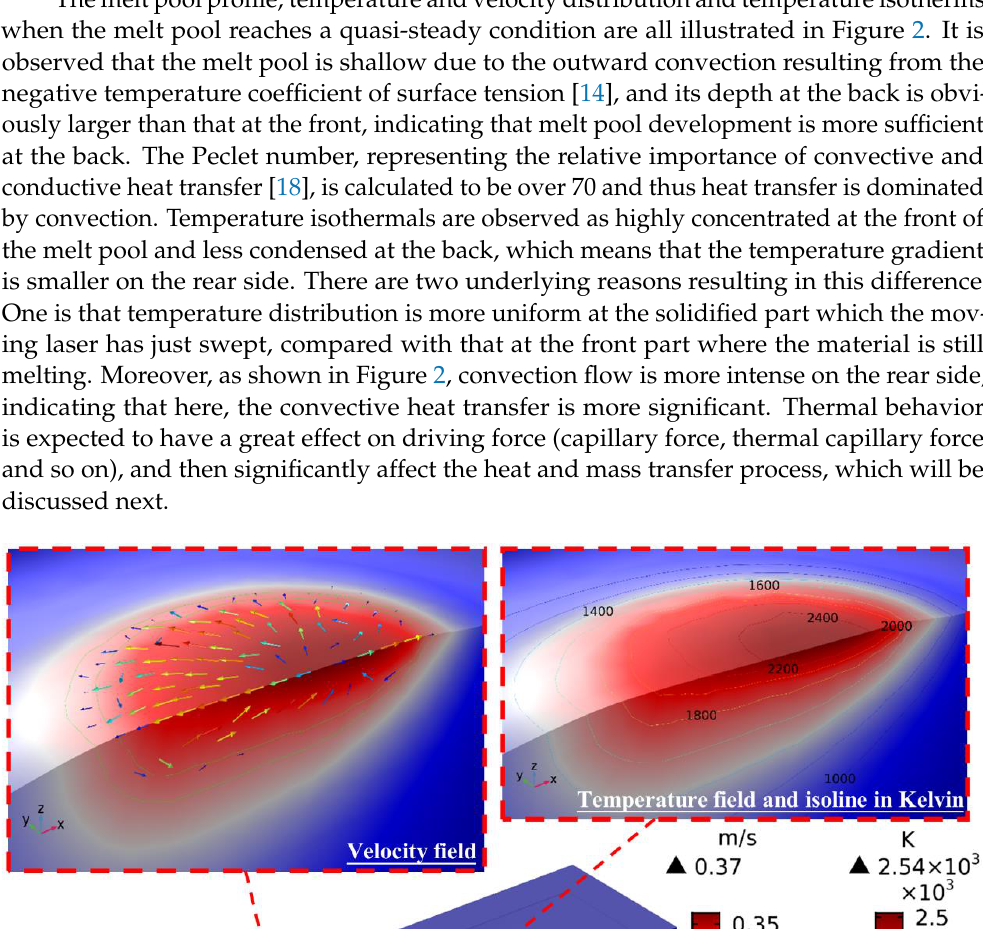
(17) If the 𝑃 𝑟 is much larger than 1, the fusion boundary is dominated by the momentum boundary, while it is mainly affected by the thermal boundary when 𝑃 𝑟 is much smaller